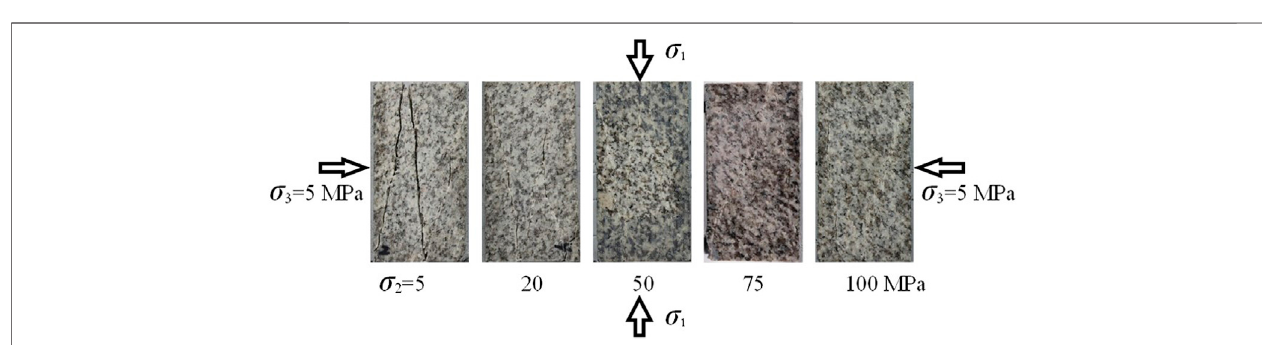
FIGURE 6 | Failure modes of tested granite change with σ 2 when σ 3 is 5